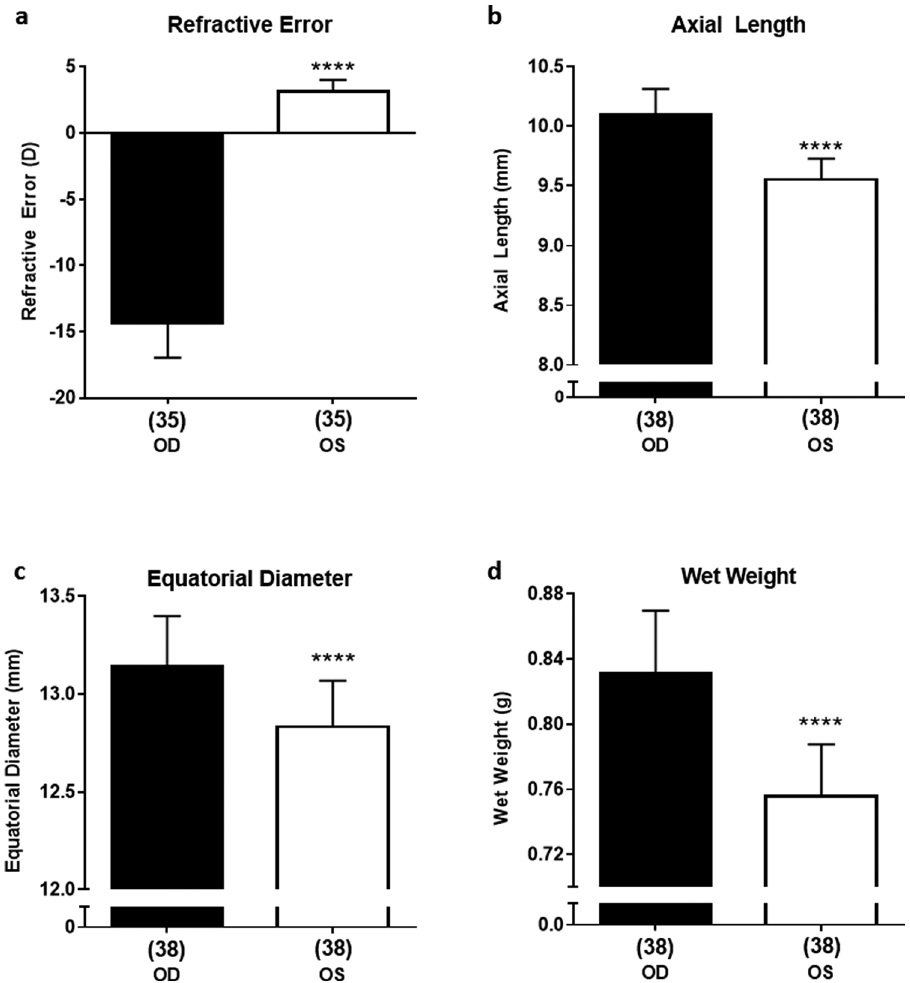
Figure 1. Refractive and biometric interocular differences between goggled (form-deprived right eye: OD) and non-goggled (open left eye: OS) eyes, after injecting phosphate-buffered saline (PBS) 3 times, at 48-hr intervals. Monocular form-deprivation of chicks in this study caused the expected responses: a large negative shift in refractive error ( a ), and modest but highly significant increases in total axial length ( b ), circular- equivalent equatorial diameter ( c ), and wet weight ( d ), in the goggled eyes. Data are represented as absolute mean ± standard deviation. Statistics: **** p < 0.0001, unpaired Student’s t -test; sample sizes (n) are denoted in brackets below each